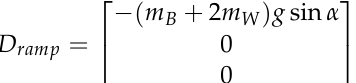
Figure 5. Examples of matched and unmatched disturbances. A great part of the lumped disturbance acting on the TWIP robot can be classified as unmatched disturbances, e.g., model parametric errors, rolling resistance due to the tire flat- ness, wheel–slip phenomena, the eccentric center of the gravity of the pendulum from the wheel axis, and most importantly, the environmental disturbance by the inclined terrains. If the effective slope angle in Figure 2 is considered in the nominal model Equation (1), the pitch angle θ in the elements of matrices of M and C is changed to θ + α , as shown in Appendix A, and the first element of the gravity vector has g 1 = ( m B + 2 m W ) g sin α [16,20]. As the static equilibrium condition in Equation (2) implies, this additional gravity term arising from the unknown terrain, as denoted in Figure 5, dominantly affects the veloc- ity tracking performance and the upright posture stabilization of the TWIP as a wheel disturbance. Assuming only a ramp disturbance due to terrain uncertainty, the lumped disturbance of the TWIP at a steady state can be represented by